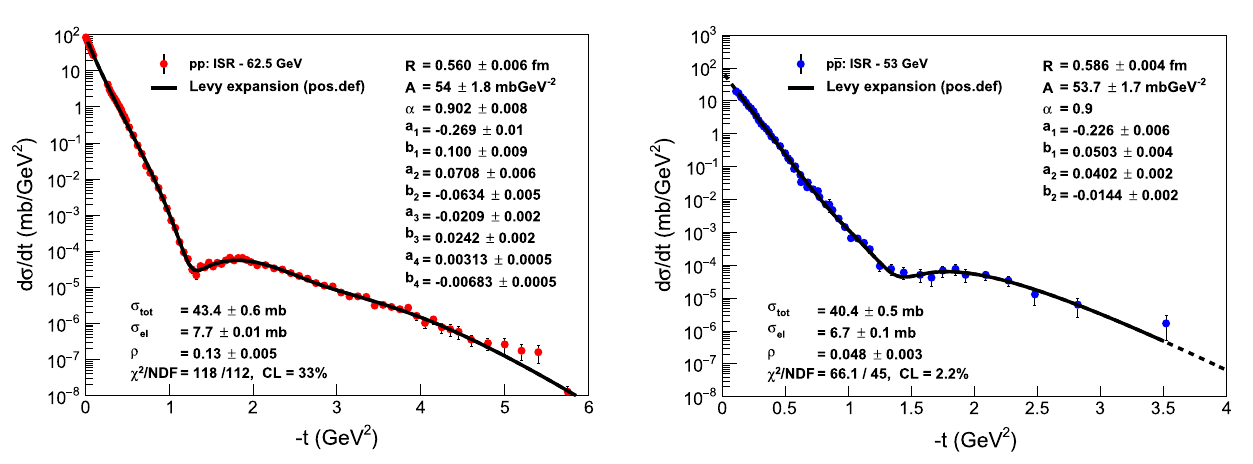
Fig. 25 Second-order Lévy expansion fits of the differential cross- √ s = 62 . 5 section data on p ¯ p elastic scattering at α = 0 . 9